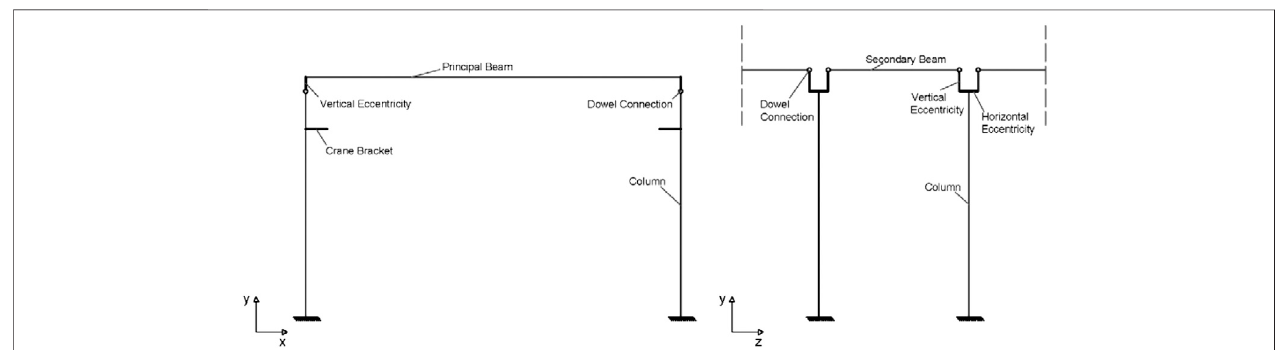
FIGURE 5 | Structural scheme.